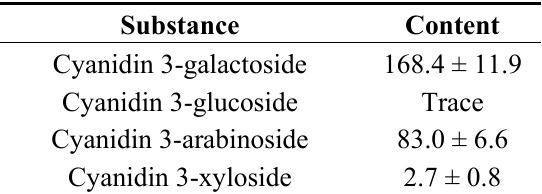
Table 2. Content of anthocyanins in aronia berries (as mg cyanidin 3-galactoside equivalents from 100 g fresh weight).